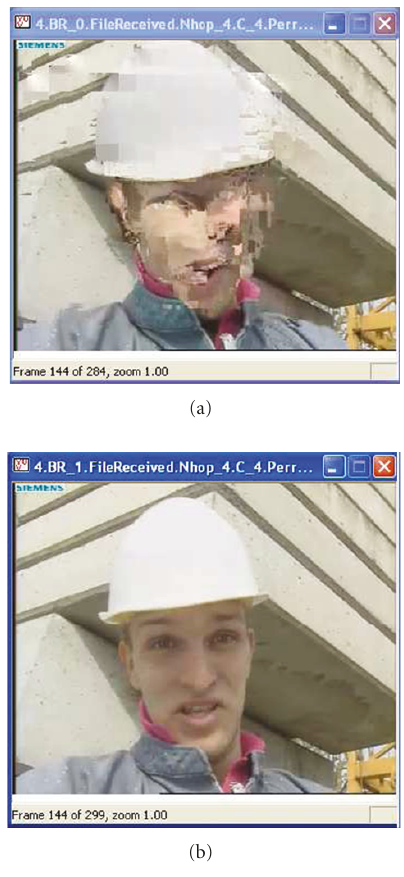
Figure 12: Comparison of two video sequences quality at frame number 145: (a) reference and (b)